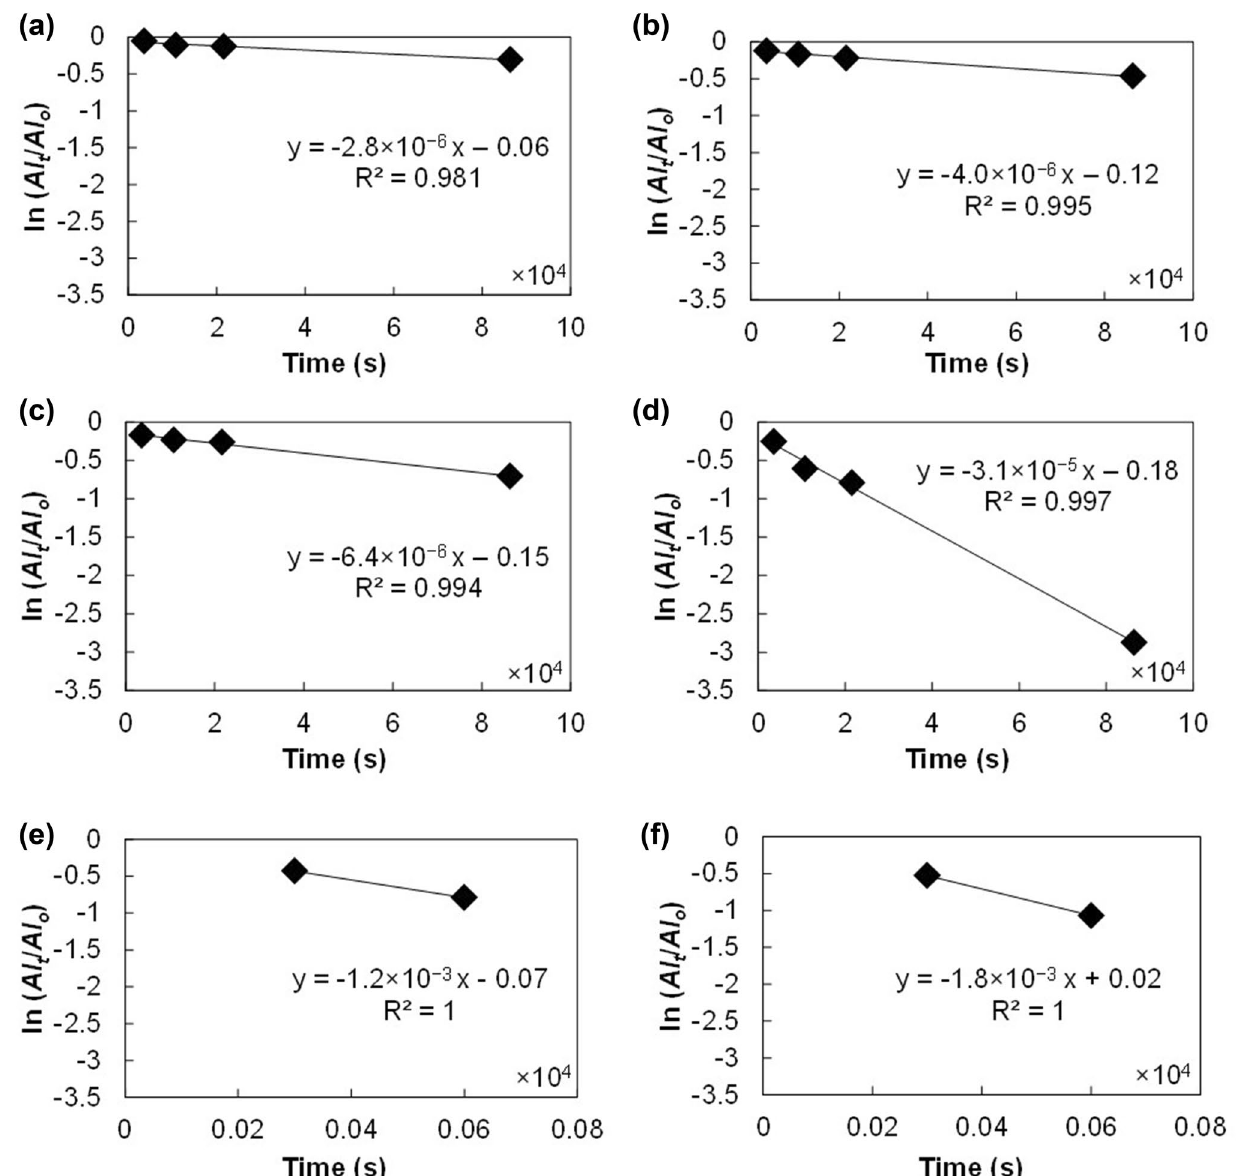
Fig. 8 Change in amount of aluminum as a function of time at a 230 °C, b 250 °C, c 270 °C, d 280 °C, e 290 °C, and f 300